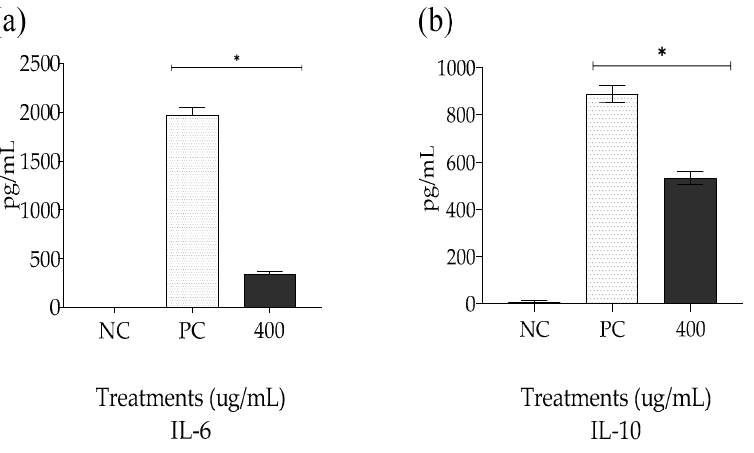
Figure 7. Mean ± SD of the levels of the interleukins IL-6 ( a ) and IL-10 ( b ) (pg/mL) for each treatment group: negative control (NC; untreated cells), positive control (PC; LPS), and EPPR (400 µ g/mL). The asterisk (*) indicates a significant difference ( p < 0.05) compared with the NC. One-way ANOVA followed by Tukey’s post hoc test.